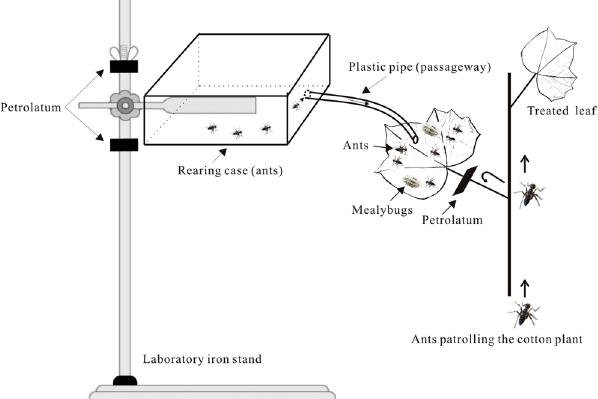
Figure 5. Diagram of the set-up used in experiment 4 to determine whether patrolling ants are attracted to plants with ant-tended mealybugs. The treatment illustrated is MA2, which is described in Fig. 6 and in the